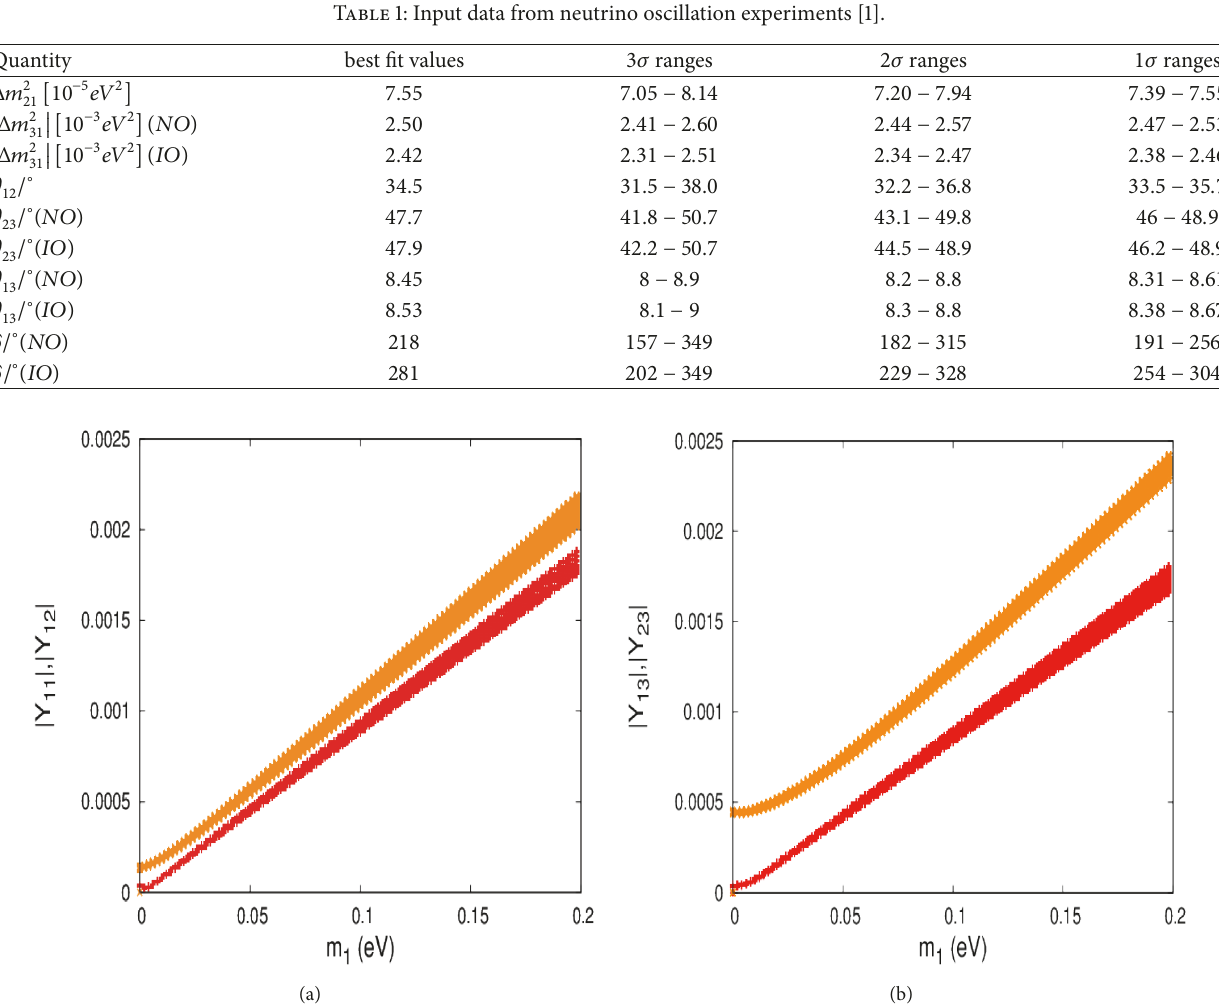
Figure 2: Determination of moduli of 𝑌 matrix elements within 1𝜎 uncertainty of oscillation data as a function of lightest neutrino mass eigenvalues 𝑚 1 . Phase angles used are randomly chosen Majorana phases 𝛼 푀 = 37.91 ∘ , 𝛽 푀 = 157.91 ∘ and central value of the Dirac phase 𝛿 = 216 ∘ . In (a) red and yellow regions denote 1𝜎 allowed values |𝑌 yellow region denotes the same for |𝑌 23 | within the same uncertainty of the oscillation